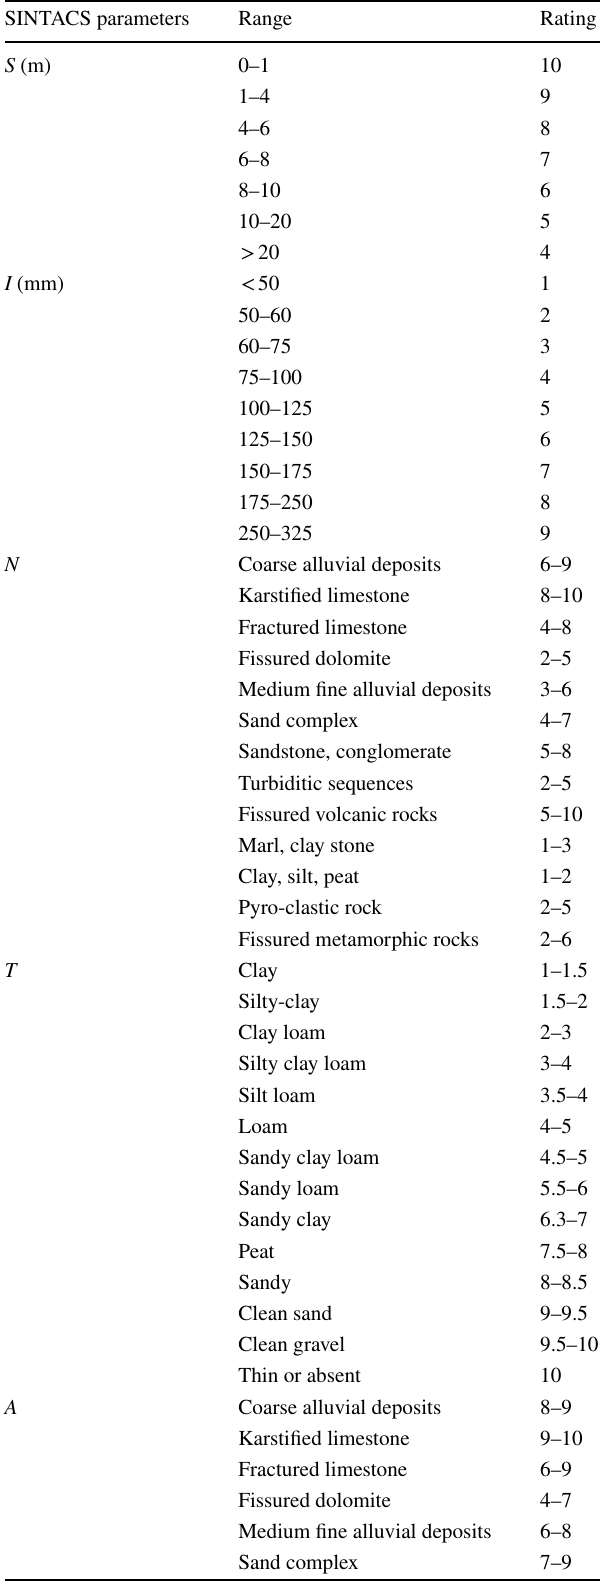
Table 2 Ranges and ratings of SINTACS parameters (Civita and De Maio